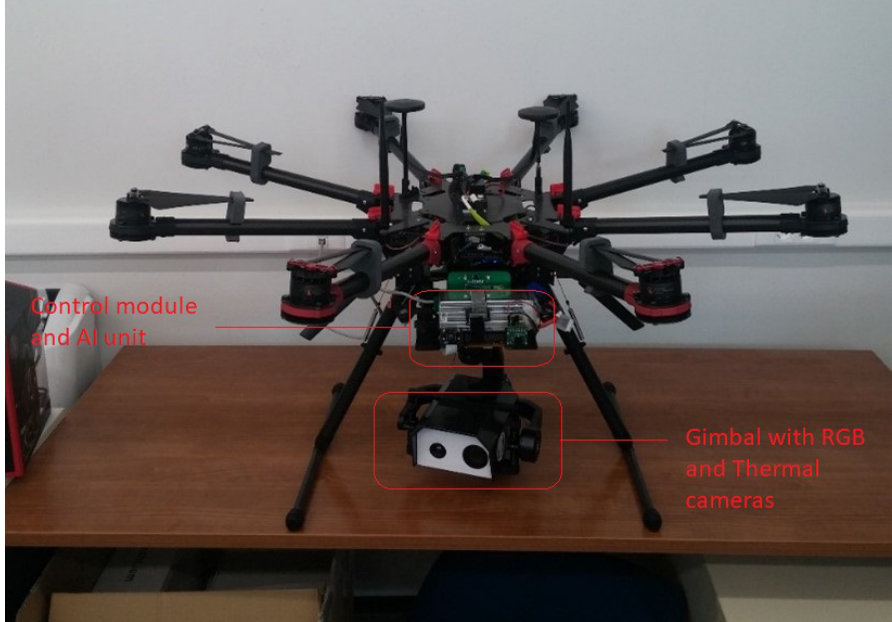
Figure 1. The specially designed octocopter UAV showing the processing module container at its central unit, as well as the gimbal that carries the thermal and RGB cameras suspended